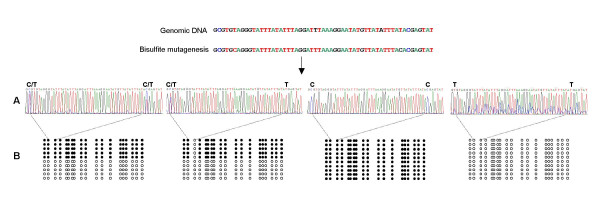
Methylation analysis of individual blastocysts by bisulfite conversion followed by direct sequencing and cloning/sequencing. For each analyzed blastocyst, bisulfite mutagenesis was performed. After PCR amplification the methylation status of CpG positions was determined by direct sequencing (Figure 5A) and cloning/sequencing (Figure 5B). When Single Nucleotide Polymorphism (C/T) was observed by direct sequencing, the proportion of C in the clone sequences was approximately 50%. When only C or T were detected by direct sequencing, all sequences of analyzed clones presented a methylated or an unmethylated status respectively. Reading the direct sequences, for each blastocyst, the presence of C/T, C or T at one CpG position is represented by the black (methylated) and white (unmethylated) lollipops (Figure 5C).